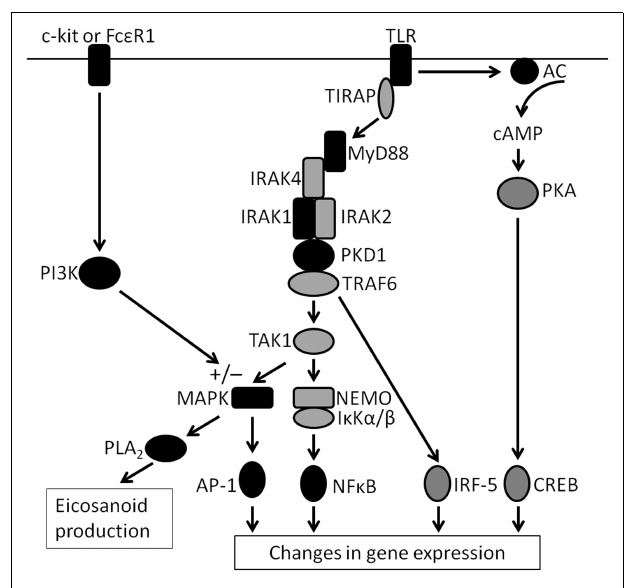
FIGURE 1 | Mast cell secretory responses toTLR ligation. A diagram showing the molecules secreted by mast cells uponTLR ligation.The cytokines, chemokines, and lipid mediators released uponTLR ligand stimulation are summarized for murine BMMC, PCDMC, FSDMC, and